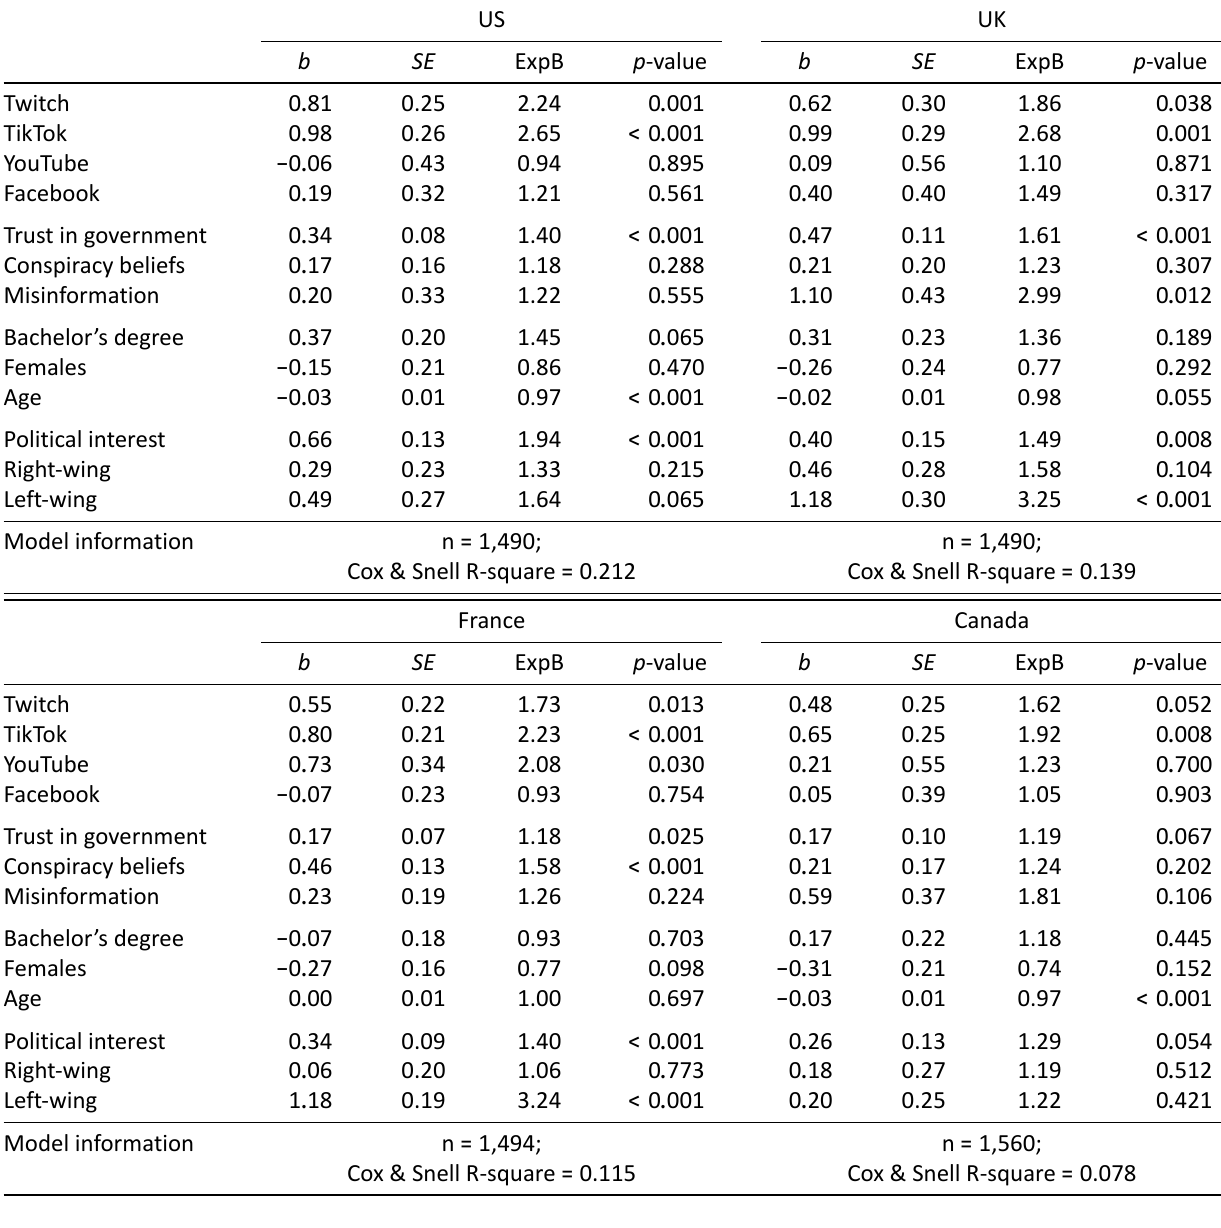
Table 4. Logistic regression of participation in marches or demonstrations for each